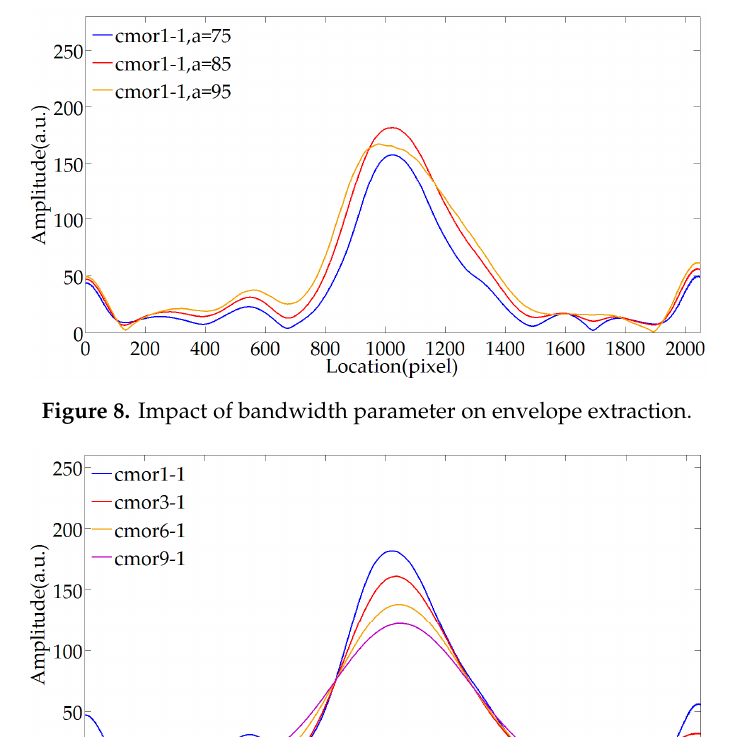
Figure 8. Impact of bandwidth parameter on envelope extraction.